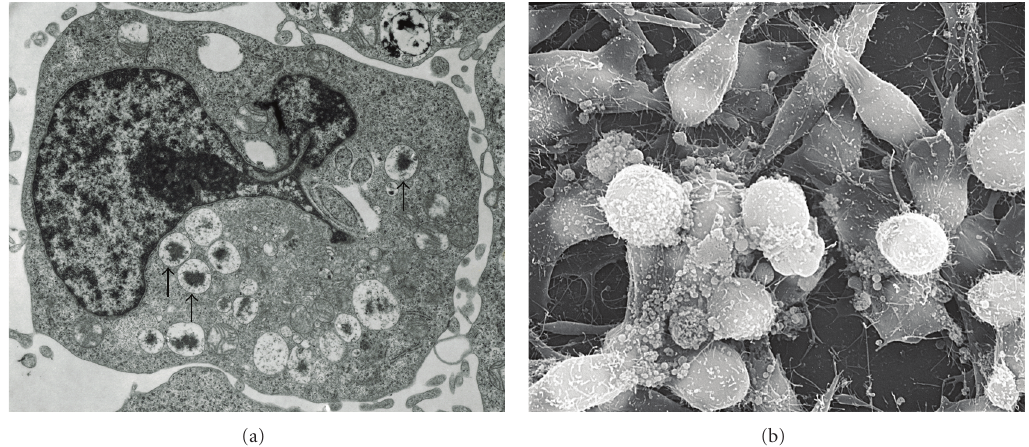
Figure 3: Transmission and scanning electron microscopy. The ultrastructural assessment of HMC-1 5C6 cells demonstrates the presence of cytopslasmic granules; (a) shows HMC-1 5C6 clone exhibited numerous electron-dense granules (arrows) indicating maturity of the cells (magnification 14,000X); (b) shows a scanning electron micrograph of HMC-1 5C6 in a typical co-culture experiment demonstrating endothelial cell-mast cell interaction (magnification 2600X).